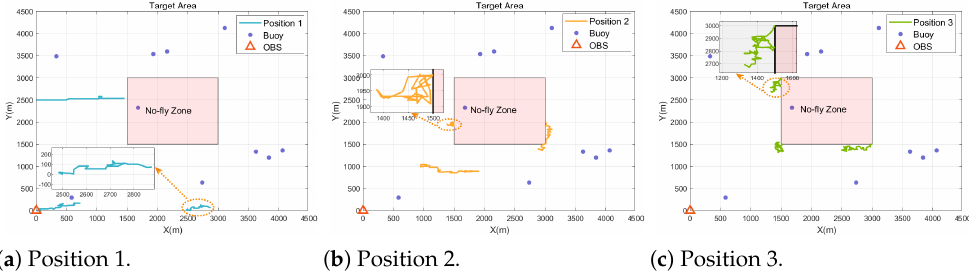
Figure 6. UAV trajectories with different initial positions of taking